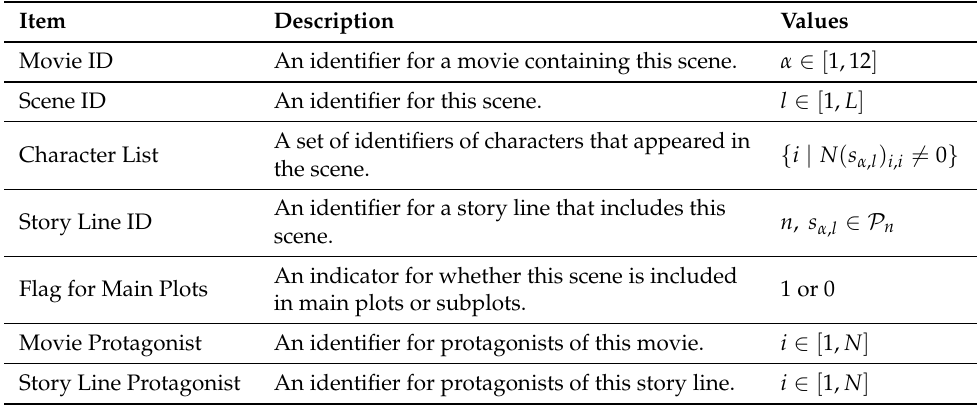
Table 2. A list of movies that have been used for evaluating the proposed methods for decomposing and analyzing plot